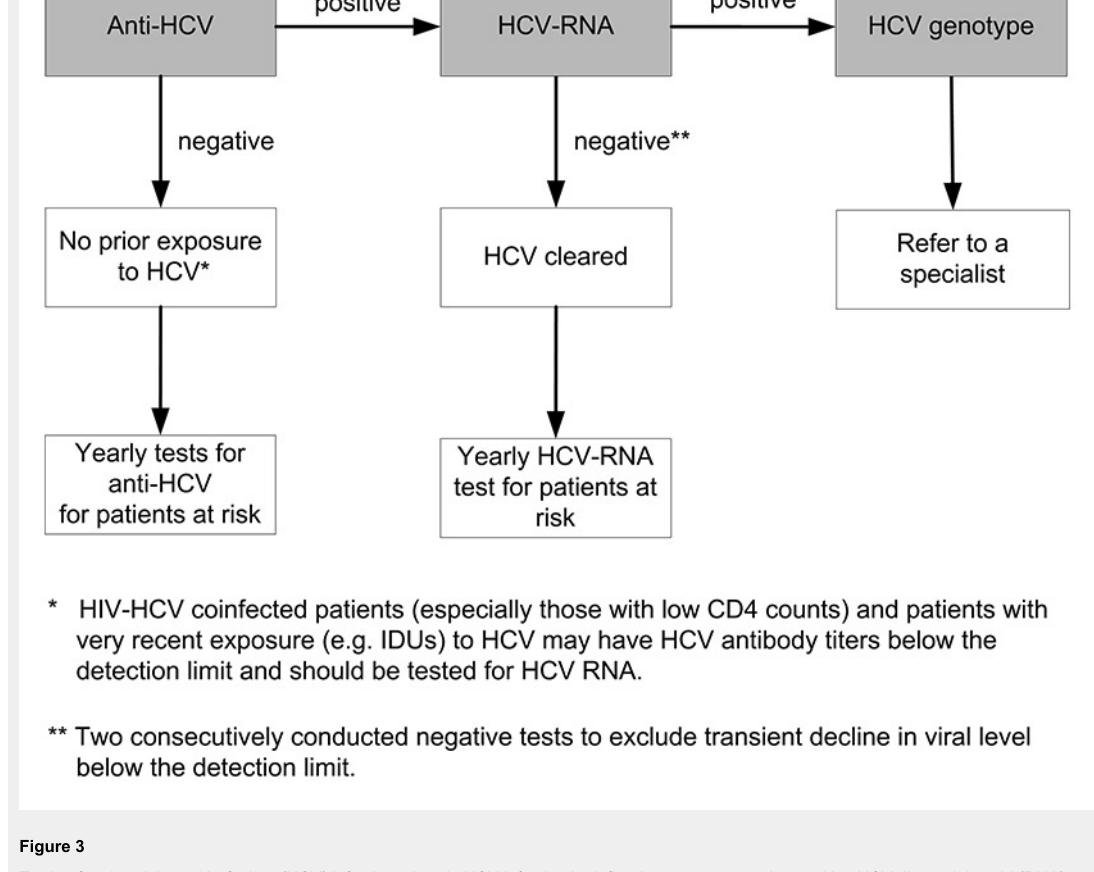
Figure 3 Testing for chronichepatitis C virus (HCV) infection: chronic HCV infection is defined as two consecutive positive HCV ribonucleic acid (RNA) tests at intervals of 6 month ■■in minimum■■. IDU = intravenous drug